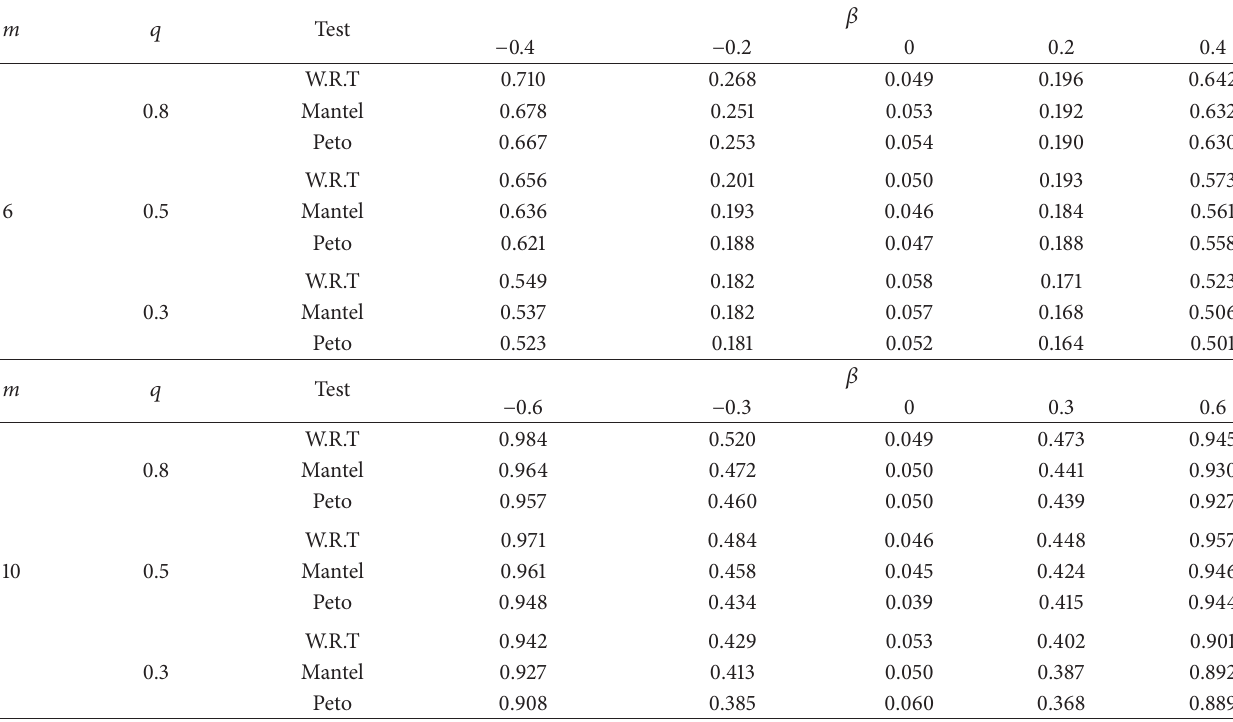
Table 6: Power comparison of tests under exponential distribution with sample 𝑛 = 200